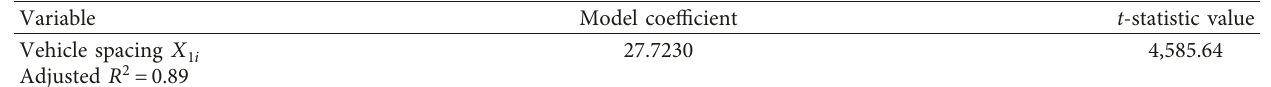
Table 6: Calibrated coefficient of the Yang et al. model.